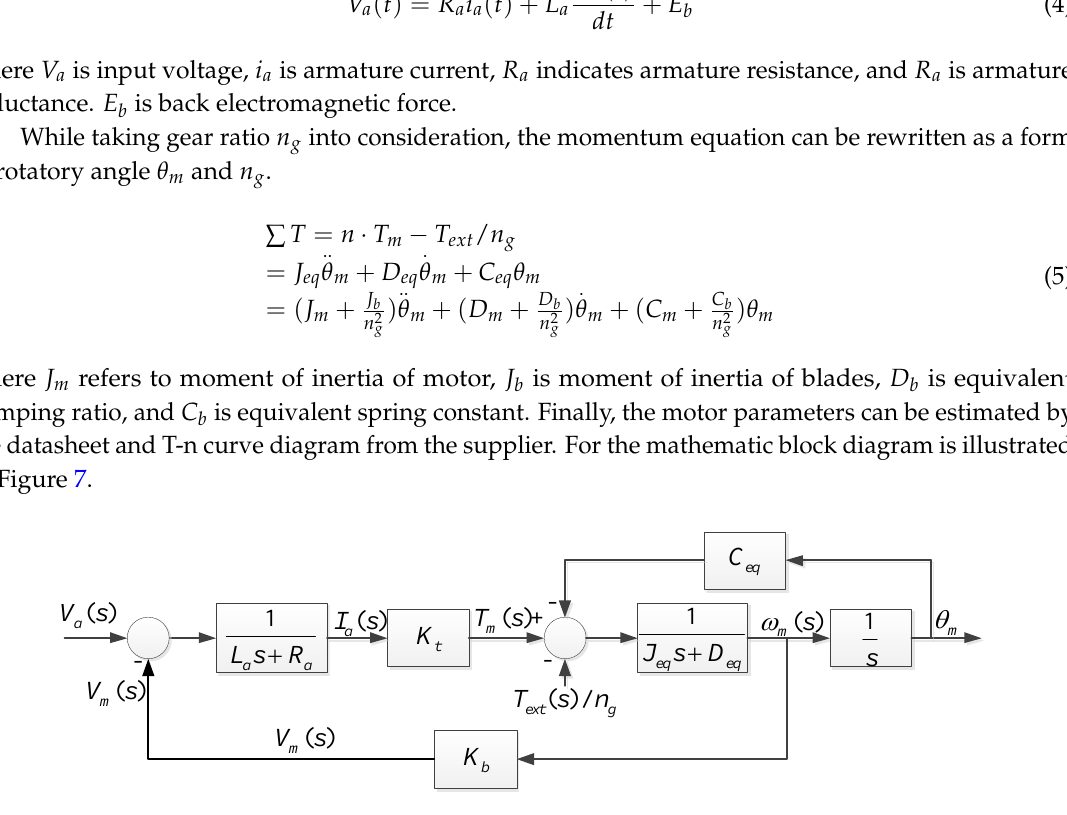
Figure 7. Block diagram of DC servo motor.